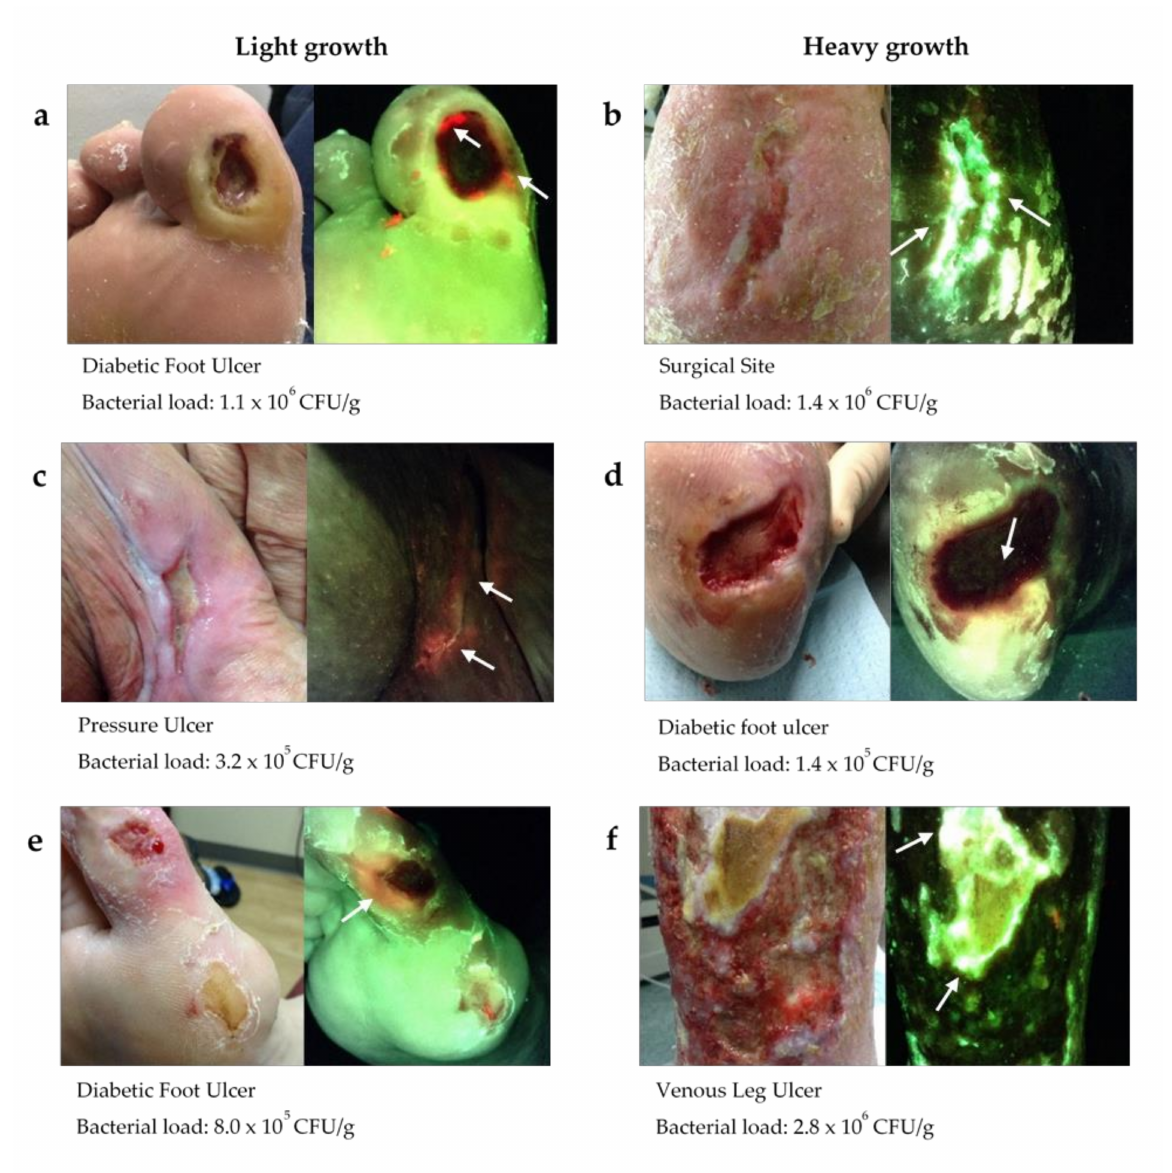
Figure 4. Wounds with bacterial loads of 10 5 –10 6 CFU/g via quantitative culture where ‘light’ or ‘heavy’ growth was indicated via semi-quantitative culture. Maximum bacterial load obtained by quantitative culture analysis is listed below each example. Fluorescence images (MolecuLight i:X) revealed red or cyan fluorescence (denoted with white arrows) indicative of bacterial loads >10 4 CFU/g in all wounds listed above. Regions of cyan in panels ( b , f ) were confirmed as Pseudomonas aeruginosa in these cases. Green is indicative of matrix components from tissue